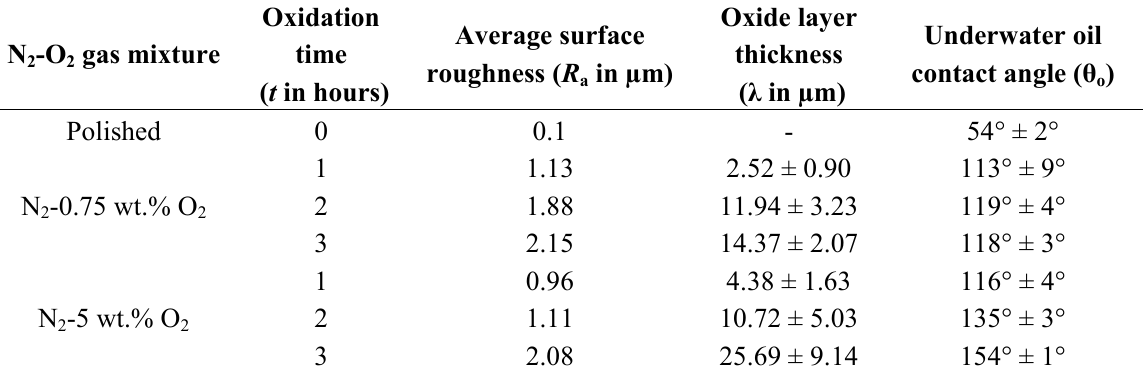
Table 2. The oxide layer thickness, average oxide granule sizes and underwater oil contact